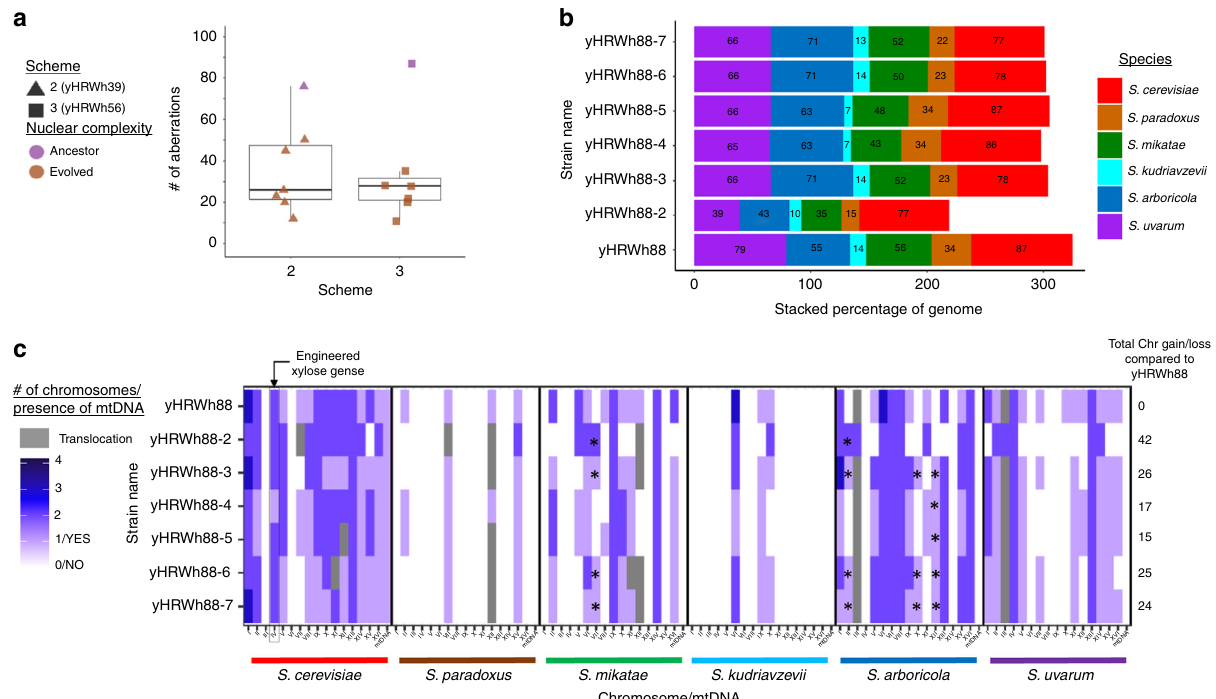
Fig. 6 Synthetic hybrids as a tool to study genome instability. a Box plots of the number of chromosomal aberrations inferred for ancestor and evolved synthetic hybrids (Fig. 2b, Supplementary Fig. 3) ( n = 1 sequenced strain). Synthetic hybrids generated from each independent scheme are represented with different shapes. Purple and brown color points represent whether six-species hybrids were ancestor or evolved, respectively. Median values are represented by a horizontal line inside the box, and the upper and lower whiskers represent the highest and lowest values of the 1.5 × IQR (interquartile range), respectively. b For each colony isolated from the population sample of the evolved synthetic hybrid yHRWh88, the genome contribution of each Saccharomyces species is stacked, and the percentage of retention is indicated inside the bar plot. The percentage of each species ’ contribution are colored according to the legend. c The number of chromosomes were inferred from sppIDer plots and corrected based on fl ow cytometry. The chromosome content was colored according to the species donor. The numbers of chromosomes for each species are colored according to the heatmap legend. Recombinant chromosomes are colored in gray. Asterisks indicate chromosomes that were retained in a particular colony but were not observed in the evolved yHWRh88 population sample, highlighting the instability of these hybrids. S. cerevisiae chromosome IV, where the xylose utilization genes were inserted, is indicated by the black square. Source data are provided in the Source Data fi le and at